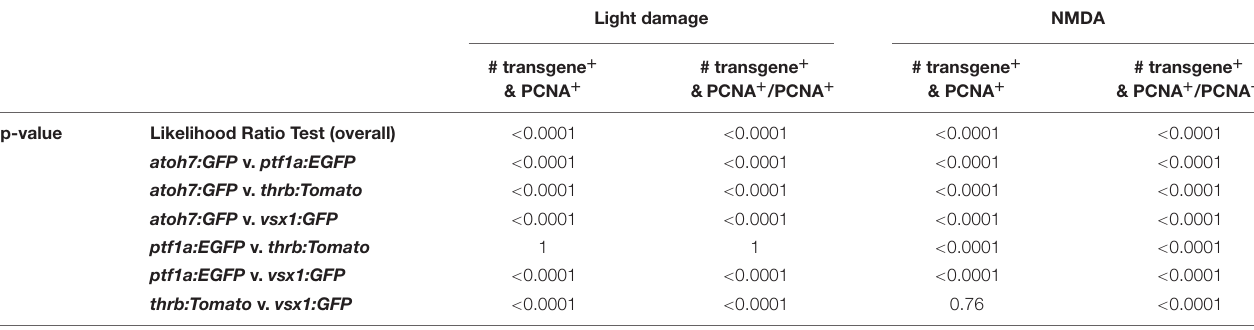
FIGURE 7 | Comparison of the temporal expression patterns of neuronal competence factors in the light-damaged retina. (A,B) Total number (ONL, INL, and GCL combined) of atoh7:GFP -, ptf1a:EGFP - , thrb:Tomato- and vsx1:GFP- positive cells (i.e., reporter-positive cells) that express PCNA (A) and when normalized to the total number of PCNA-positive cells (B) at 0, 36, 48, 60, 72, 84, and 96 hLT. Mean ± SE, n ≥ 9. TABLE 4 | p -values for the overall and pairwise Likelihood Ratio Tests for comparing transgene expression in PCNA-positive cells over time. Light damage NMDA